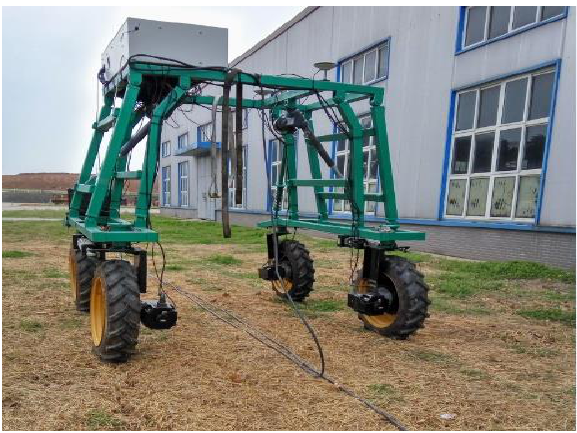
Figure 1. Developed electric distributed drive agricultural vehicle. Table 1. Main parameters of the experimental DDAV.